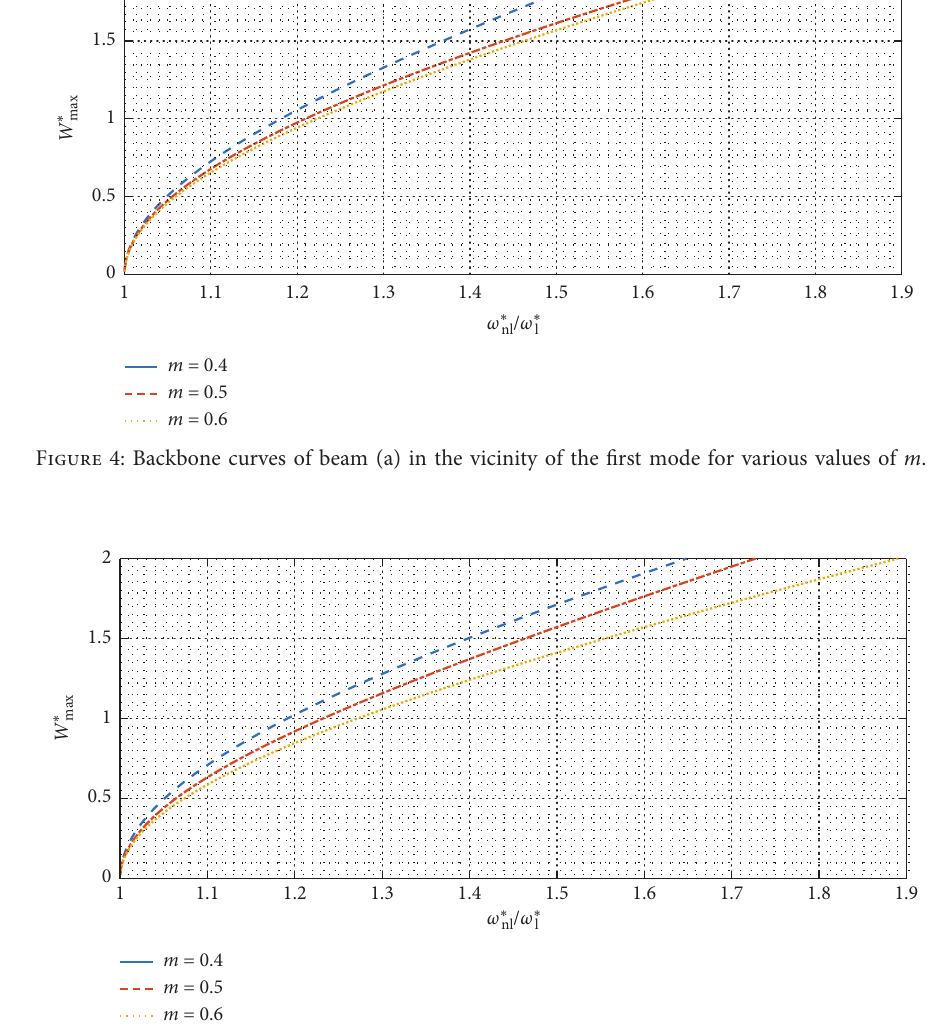
Figure 5: Backbone curves of beam (b) in the vicinity of the first mode for various values of m .